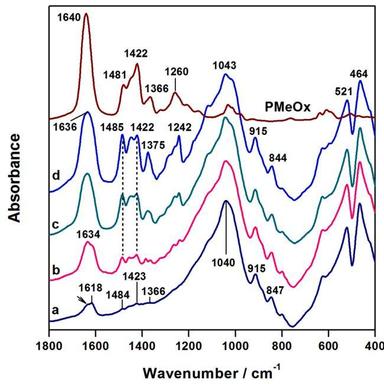
MIR spectra of PMeOx and PMeOc-Mt prepared with a) 17, b) 85, c) 340 and d) 680 mg of PMeOx per 1 g of Mt.